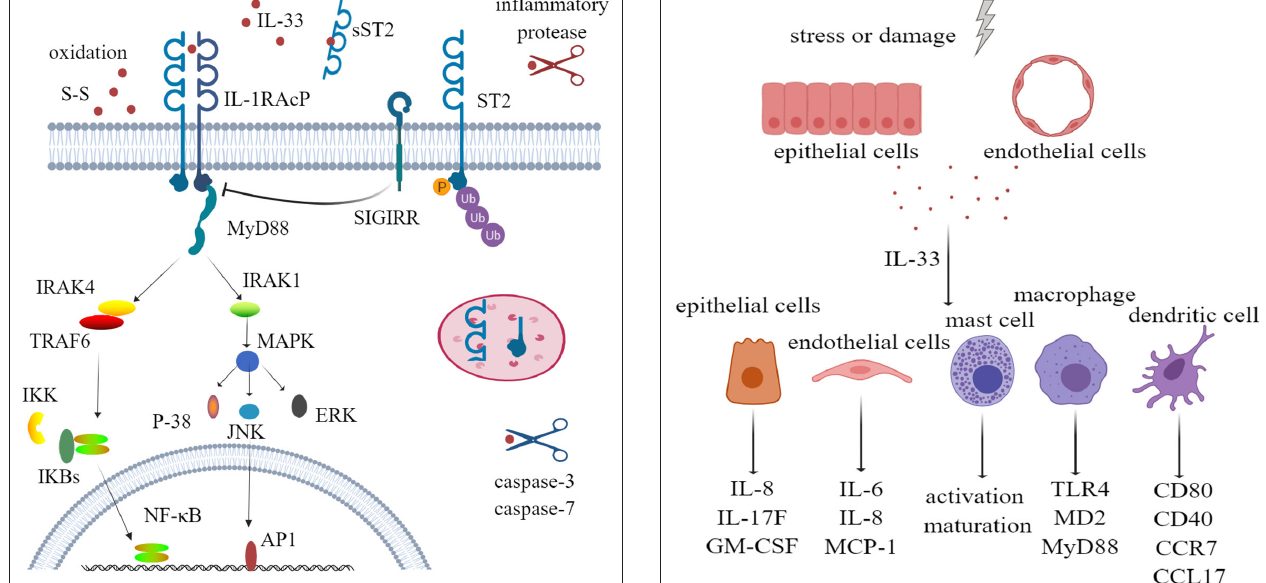
FIGURE 2 | Interleukin-33 (IL-33), as alarmin, activates tissue cells and a variety of innate immune cells. Extracellular IL-33, acting on bronchial epithelial cells, led to upregulation of IL-8, IL-17F, and GM-CSF. IL-33 also upregulated IL-6, IL-8, and MCP-1 by stimulating pulmonary endothelial cells. IL-33 not only stimulated the activation and maturation of mast cells, and upregulation of TLR4, MD2, and MyD88 in macrophages, but also upregulated CD80, CD40, CCR7, and CCL17 in dendritic cells. GM-CSF, granulocyte-macrophage colony stimulating factor; MCP-1, monocyte chemoattractant protein-1; TLR-4, Toll-like receptor 4; MD2, myeloid differentiation protein-2; MyD88, myeloid differential protein-88; CCR7, cxc chemokine receptor 7; CCL17, chemokine (C-C motif) ligand